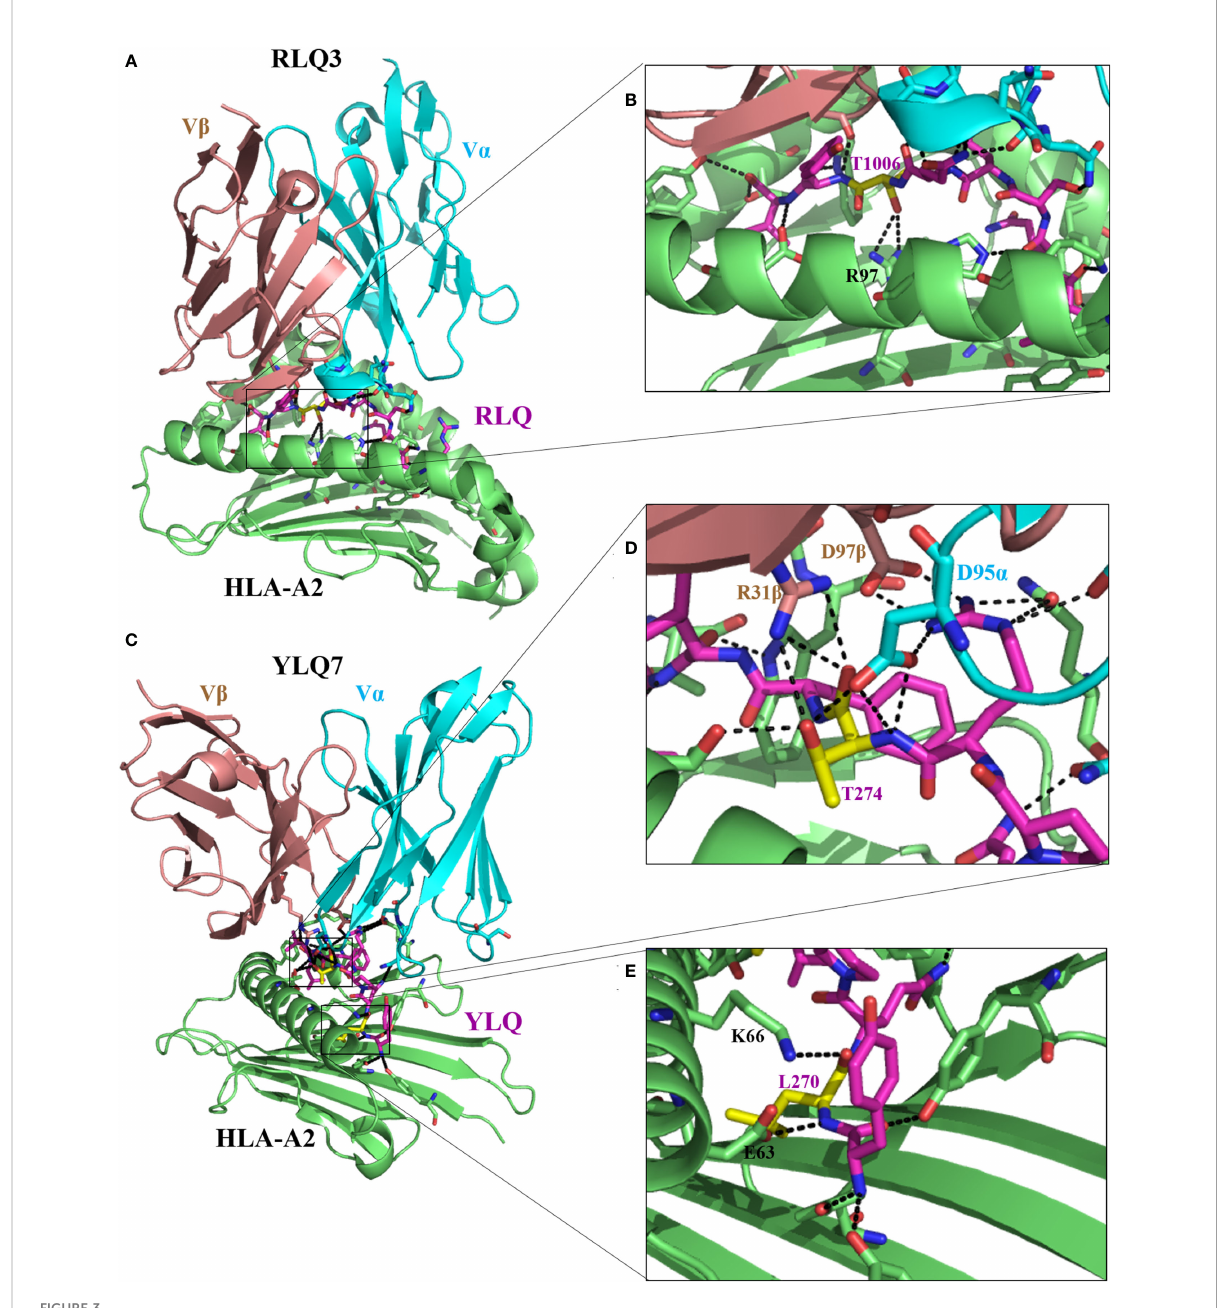
FIGURE 3 Molecular bases of TCR – epitope – HLA-I complexes and effects of epitope mutations. (A) Overview of RLQ3 – RLQ – HLA-A2 complex (7N1E). (B) Close-up view of interactions of T1006 (yellow), residue with predominant mutational rates in VOCs, with TCR RLQ3 and HLA-A2. (C) Overview of YLQ7 – YLQ – HLA-A2 complex (7N1F). (D, E) Close-up view of interactions of T274 and L270 (yellow), with TCR YLQ7 and HLA-A2. For all the structures, HLA heavy chains are green, the SARS-CoV-2 peptides are purple, while residues with a predominant mutational rate with an effect on immune escape are shown in yellow. Residues at the interface of the interaction of HLA with peptides are represented: nitrogen atoms in blue, oxygen atoms in red, and hydrogen bonds are indicated by black dashed